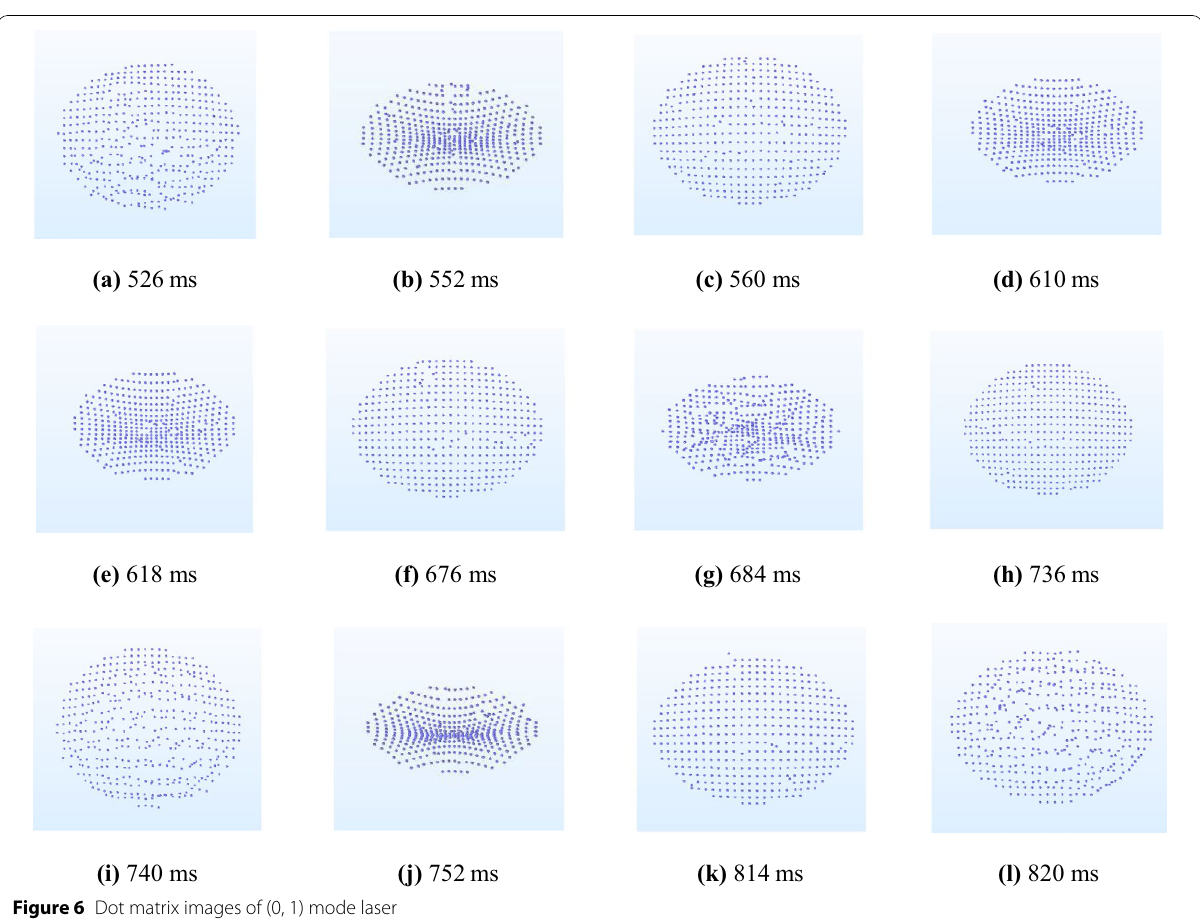
Figure 6 Dot matrix images of (0, 1) mode